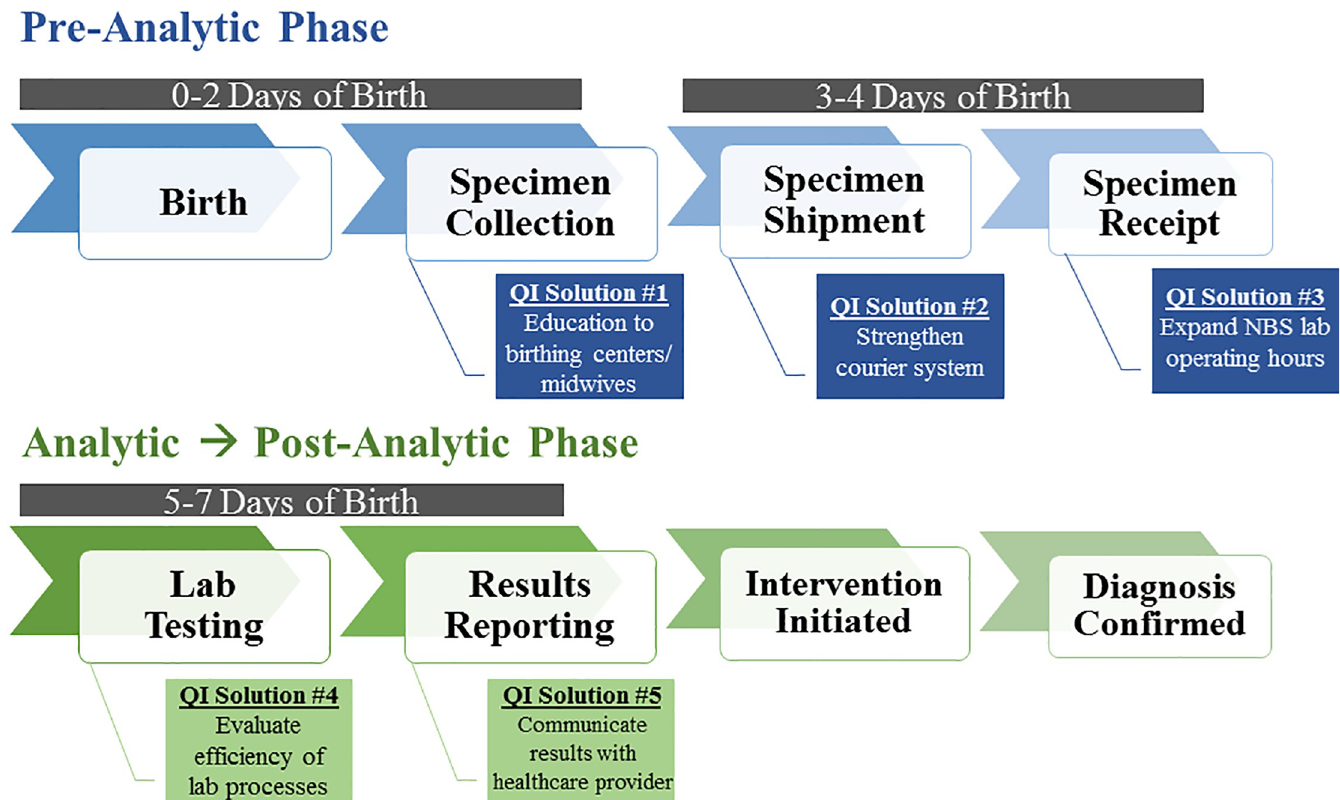
Fig 1. Newborn screening process, illustrating specimen collection through result reporting. Newborn screening (NBS) is a complex system that involves the collection of specimens at birthing facilities, transportation of specimens to the NBS public health laboratory for testing and communicating results to health care providers and families. Each step needs to occur in a timely manner in order to prevent infant mortality and morbidity. NewSTEPs 360 supported state/territorial NBS programs to address challenges associated with the pre-analytical and analytical phases of the NBS process by implementing various activities, including 1) providing education to birthing centers and midwives about the importance of timely collection and shipment of specimens; 2) shortening transit time by optimizing shipping methods; 3) expanding laboratory operating hours to decrease the time from specimen receipt to results reporting; 4) improving the efficiency of laboratory workflows; and 5) developing a health information technology infrastructure to improve the transmission of electronic demographic information, laboratory orders, and results between the NBS laboratory and health care providers.